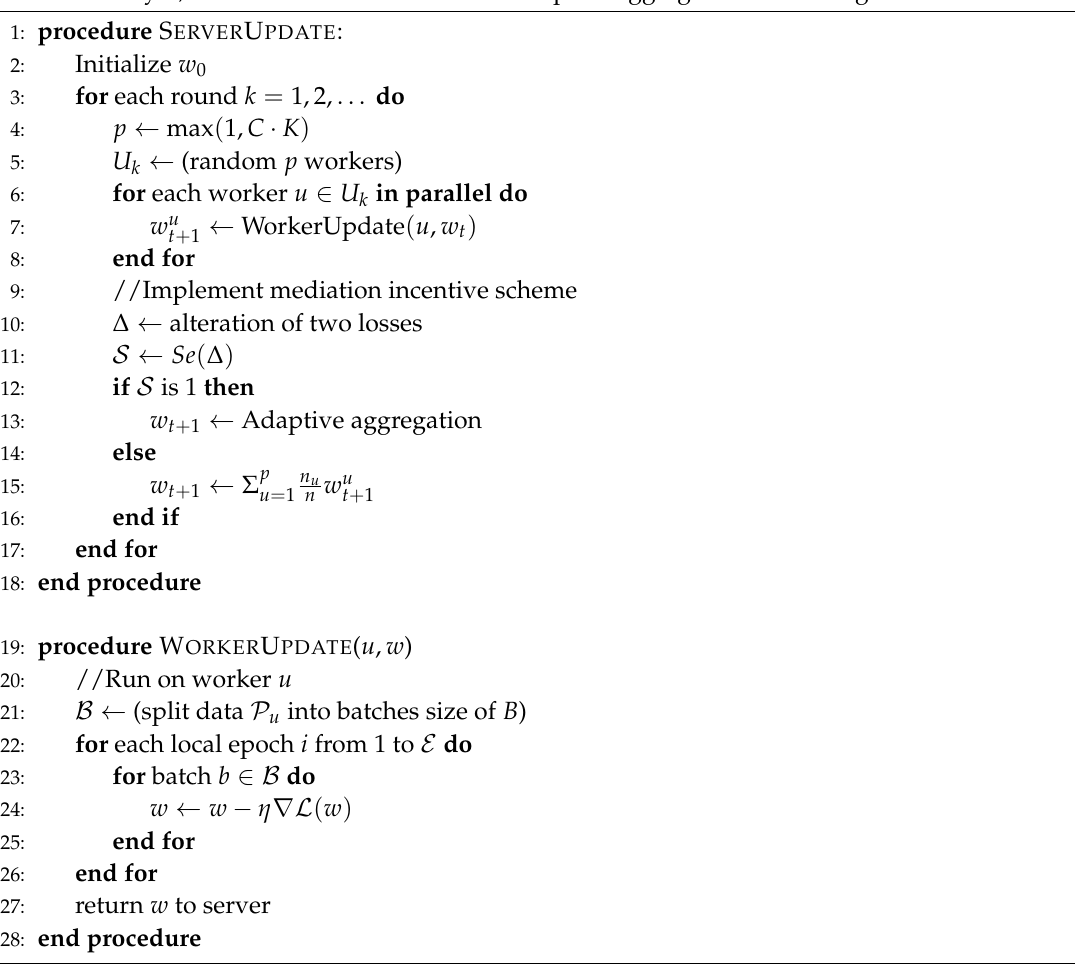
Algorithm 1 FedMed. p is the size of workers for training, E is the size of local epochs; the U workers are indexed by u , and S indicates the choice of adaptive aggregation or